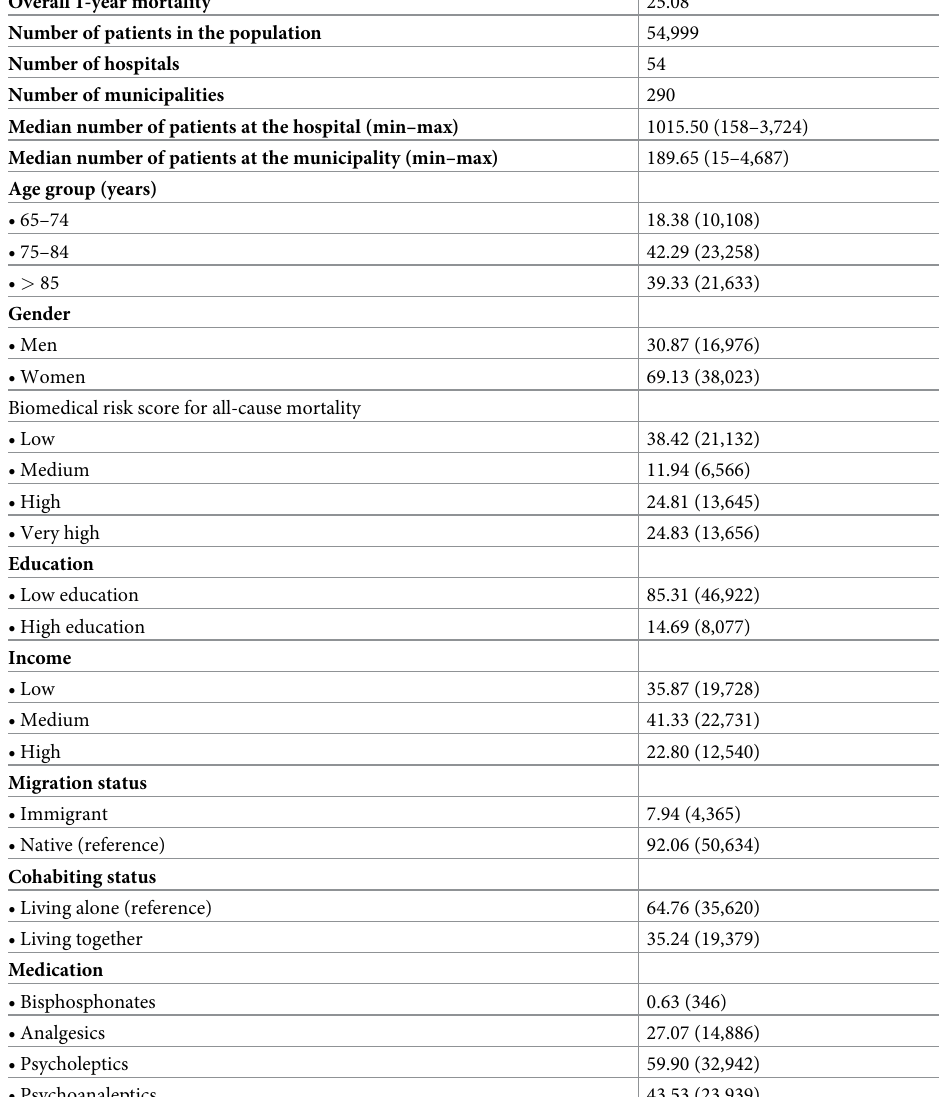
Table 1. Characteristic of the hip fracture population. Values are percentages (number of patients) if not otherwise